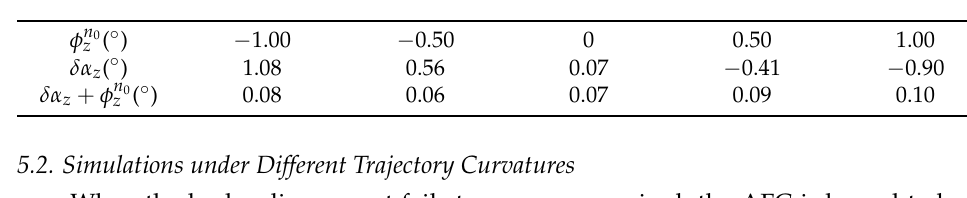
Table 2. Calibration simulation test results.